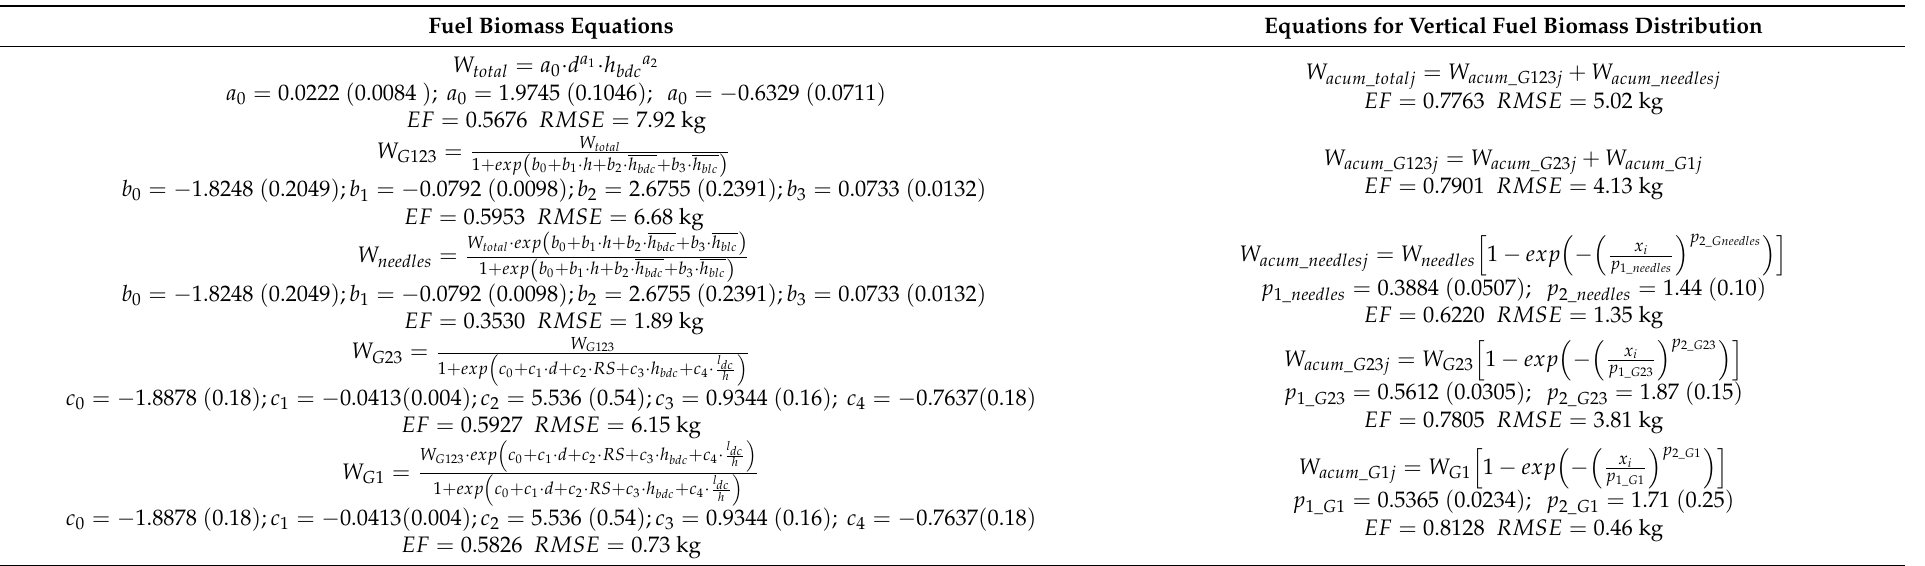
Table 2. System of 8 equations fitted to estimate dead fuel biomass and vertical distribution according to fuel fractions for individual trees. Fuel Biomass Equations Equations for Vertical Fuel Biomass